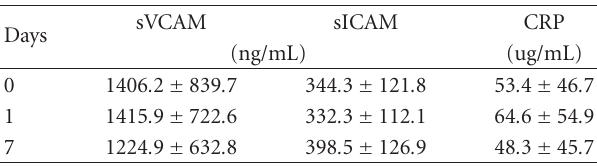
Table 3: Plasma soluble intercellular adhesion molecule (sICAM), soluble vascular cell adhesion molecule (sVCAM), and C-reactive protein (CRP) concentrations before and after the surgery.